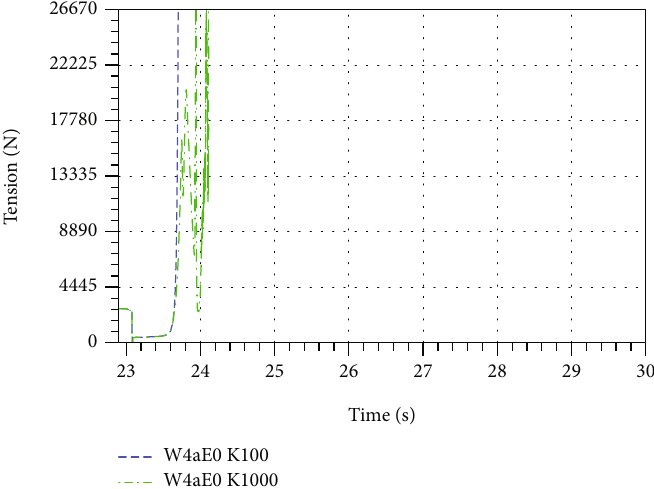
Figure 13: Case W4aE0-k tension histories with di ff erent k